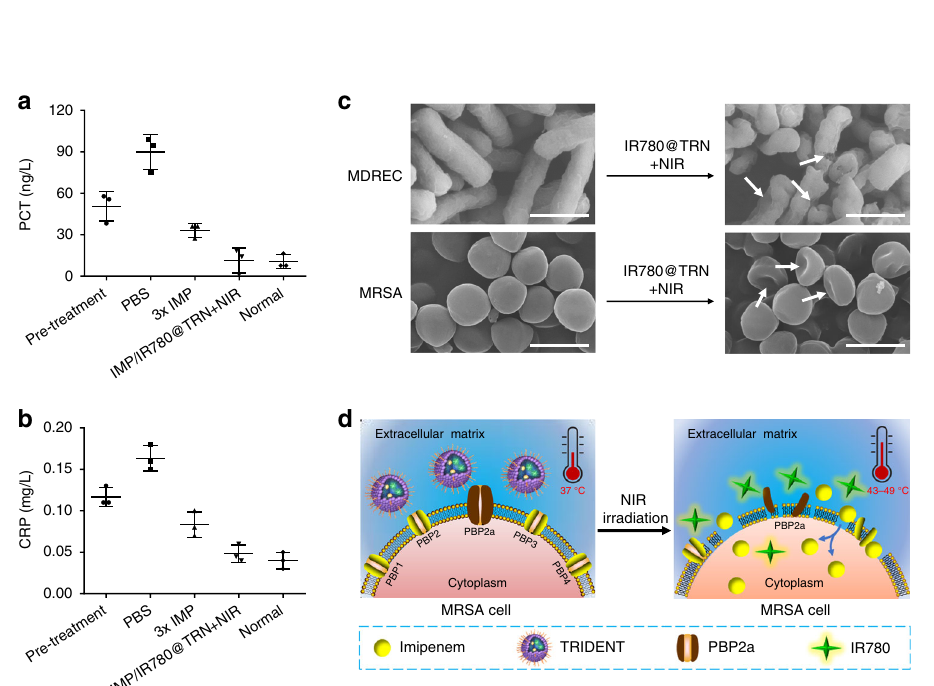
Fig. 7 The sterilization mechanism of TRIDENT. a Levels of procalcitonin (PCT) and b c-reactive protein (CRP) in blood samples from MRSA-infected mice in different treatment groups and healthy (non-infected) mice. Data are presented as mean ± s.d. ( n = 3). The control group was treated with PBS. c SEM images of bacteria before and after treatment by IR780@TRN + NIR. Scale bars: 1 μ m. d Scheme of the killing process on MRSA by TRIDENT under NIR irradiation. PBP penicillin-binding protein. Source data are provided as a Source Data fi le